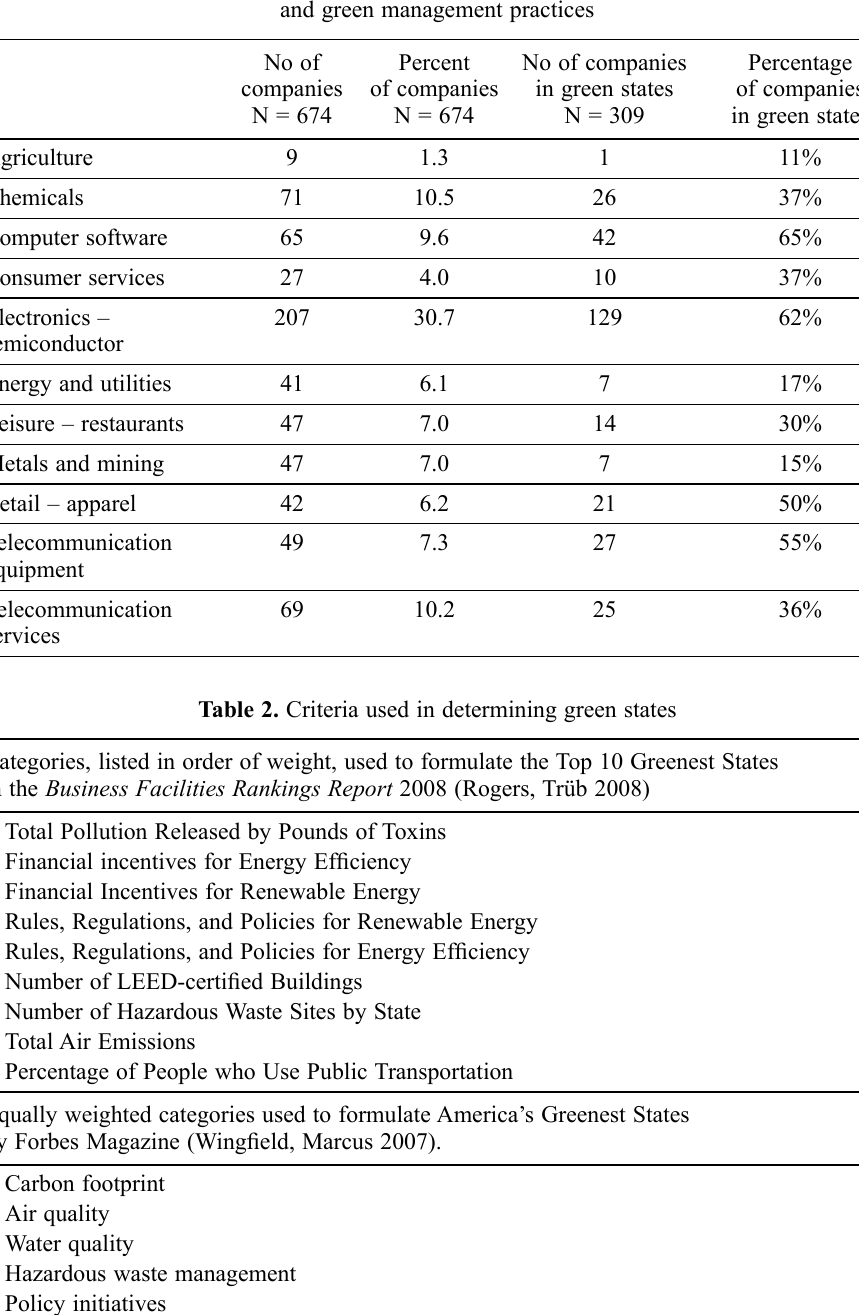
Table 1. Distribution of companies included in the study based on industry